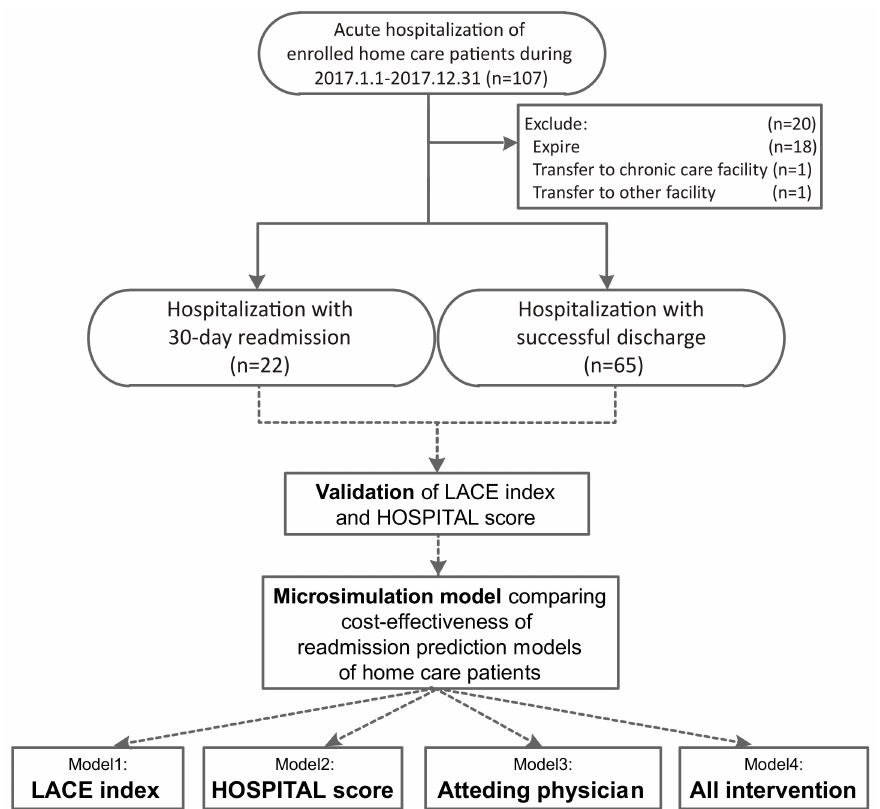
Figure 1. Flowchart of data processing for outcomes of acute hospitalization of a disabled cohort at a medical center a ffi liated home care unit in Taiwan, 2017 ( n =